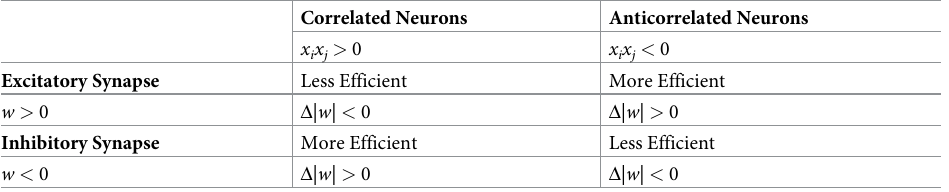
Table 1. Summary of the effect of the plasticity described in Eq (2) on excitatory and inhibitory for correlated or anticorrelated pre and post synaptic neurons. Correlated